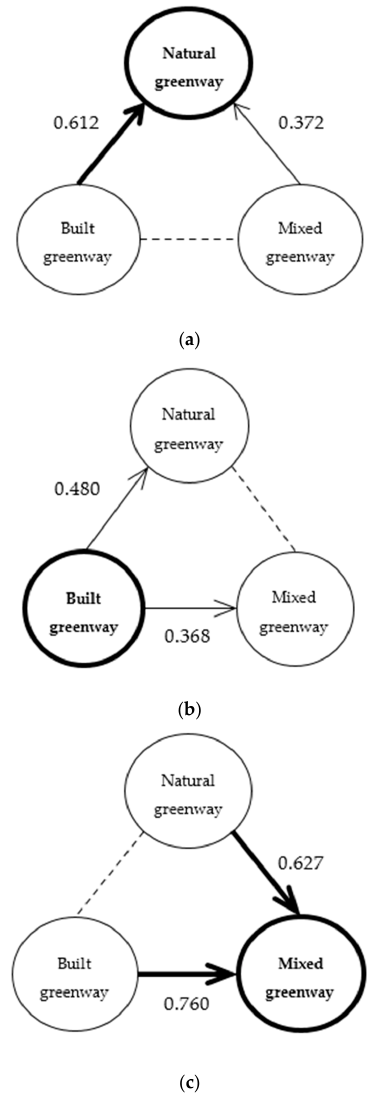
Figure 8. Comparison of greenway perception among different resident groups. Consistent with existing research results, the arrows in this figure point toward the beneficiaries and away from the injured parties. Besides, coarse arrows represent paths with relatively strong resident perceptions [50]. Thus, respondents from ( a ) natural greenways and ( c ) mixed greenways believe themselves to be beneficiaries; Respondents from ( b ) built greenways believe that they belong to the injured party.